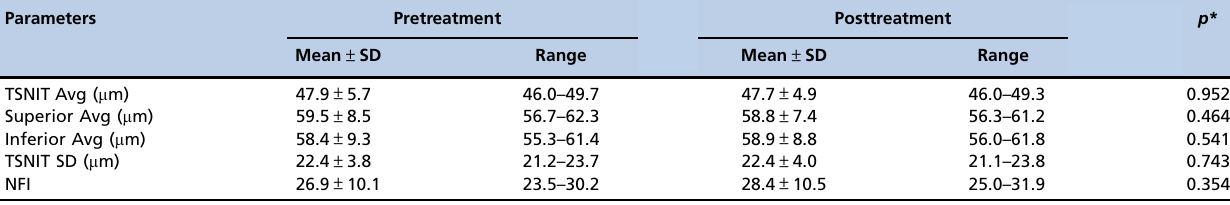
Table 1 - Comparison of scanning laser polarimetry (SLP) with variable corneal compensation (GDx VCC) parameters before and after panretinal photocoagulation (n=38).